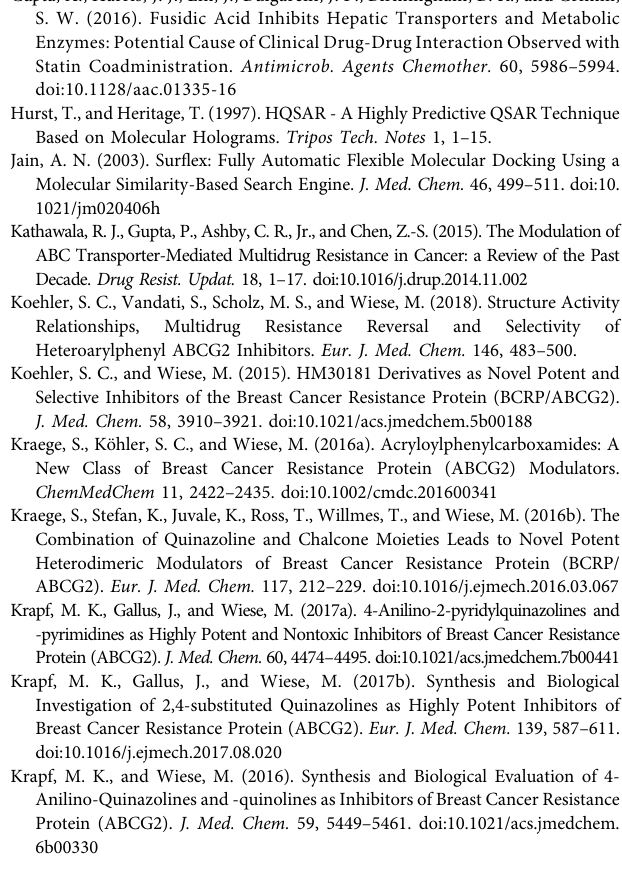
Supplementary Figure S1 | The accuracy distributions of 1000-times repeated PLS-DA modeling with randomly divided training/validation sets. Supplementary Figure S2 | Evaluation of the Sur fl ex-dock protocol. (A) Alignment of the top-scored docking pose (yellow) of the inhibitor MZ-29 (score = 9.44) on the native conformation (grey) with a RMSD of 0.83 ;Å. (B) Crucial residues involved in themolecularinteractionswithABCG2areshowninsticks.Thehydrogenbondsare shown in black dashed